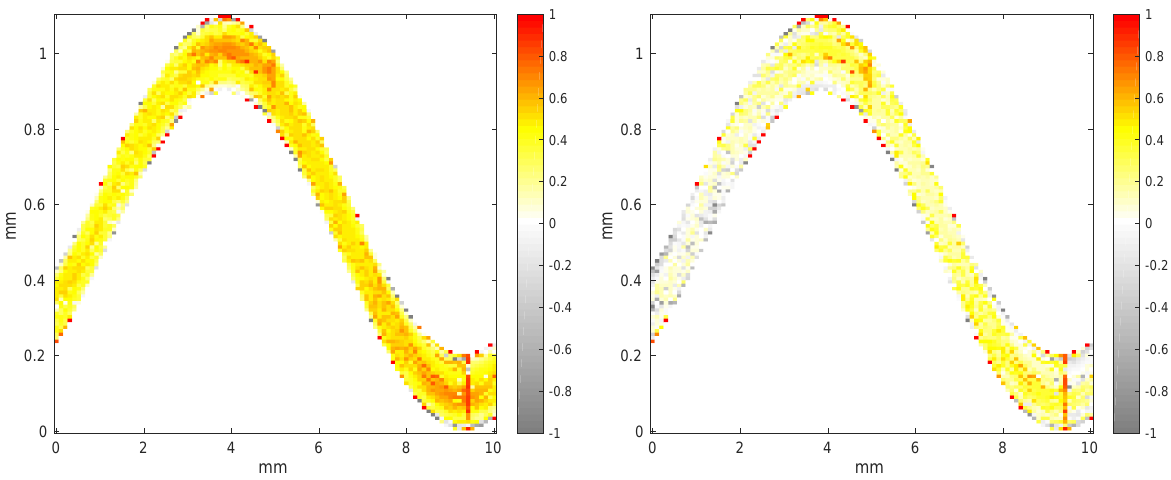
Figure 8. Relative difference of calculated diffracting volume from virtual wire profile with respect to wire profile (symbolically ( V virt − V calc ) /V virt ). On the left with fibre-texture correction, on the right with no-texture